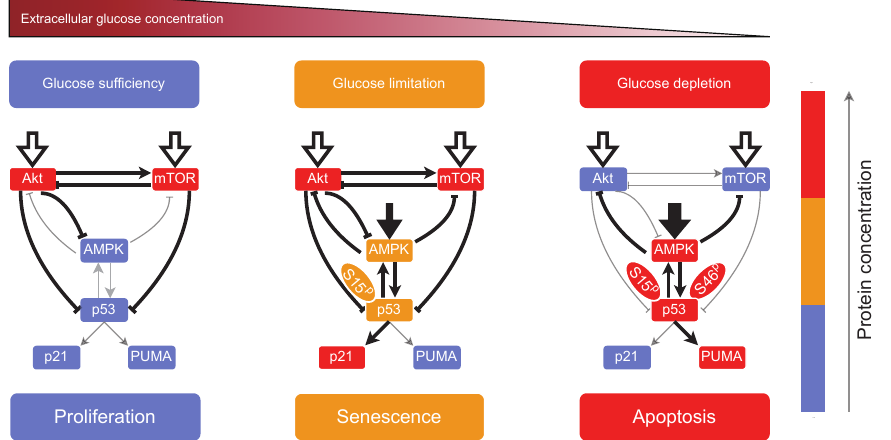
Figure 8. Schematic depiction of cell-fate decision. Cell proliferation, senescence or apoptosis can be induced by distinct combinations of protein activity. Hollow and solid arrows denote the activation from growth factors (amino acids) and glucose starvation, respectively. Arrow- and bar-headed lines separately denote the (in)direct promotion and inhibition between proteins, and grey lines label weak interactions. The color of small boxes marks the level of protein concentration. S15 P and S46 P separately refer to the phosphorylation of p53 on Ser15 and